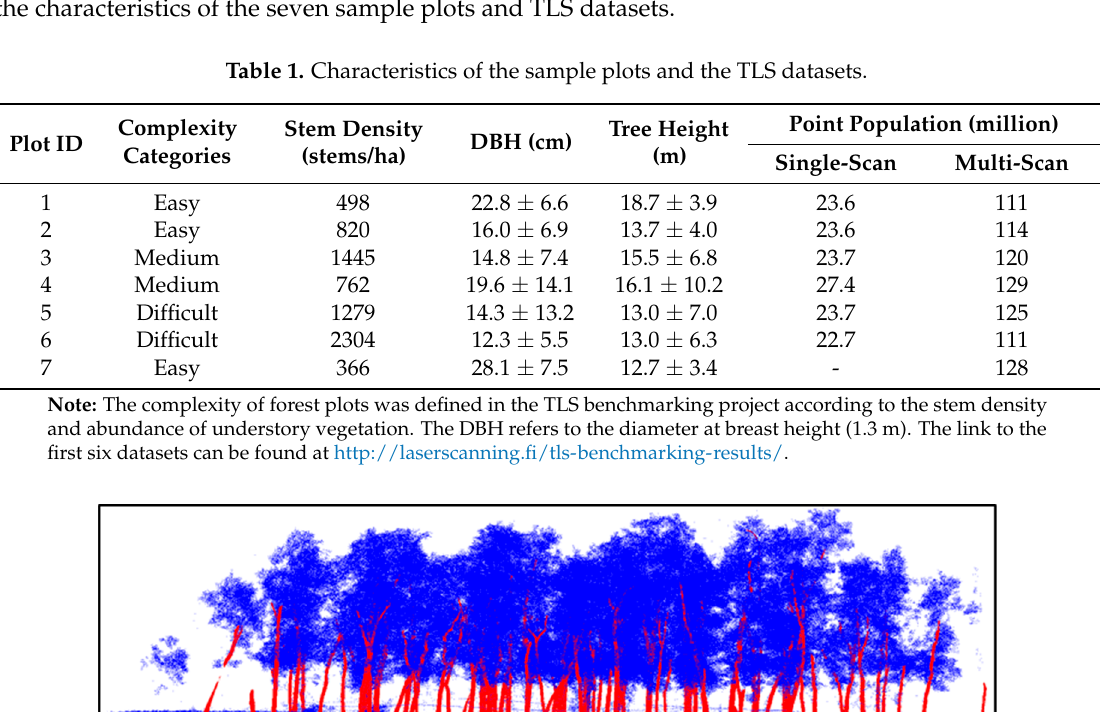
Table 1. Characteristics of the sample plots and the TLS datasets.